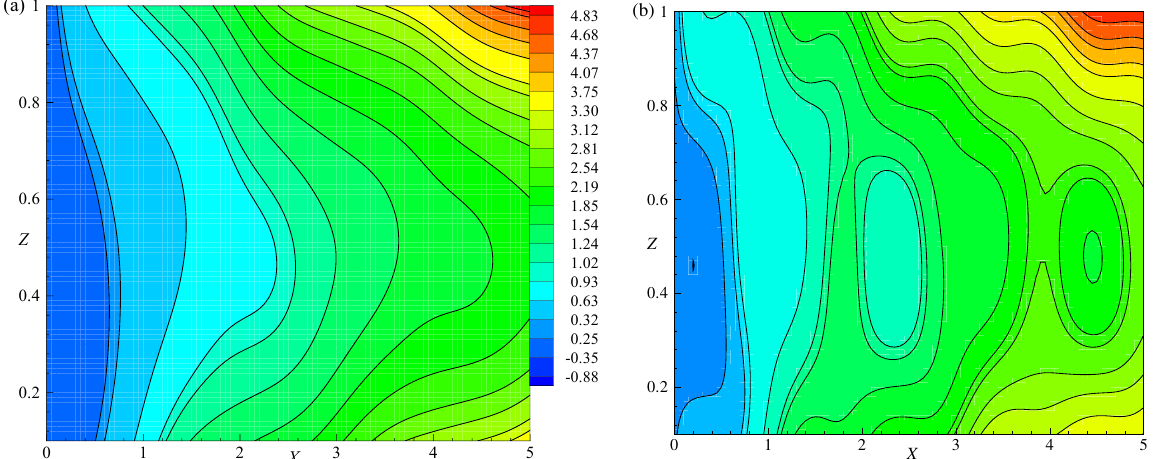
Figure 17. Heatlines at t = 0.1 ( a ) and 0.5 ( b ) for Le = 0.04, ψ = − 0.03, χ = 0.2, R = 3 R co